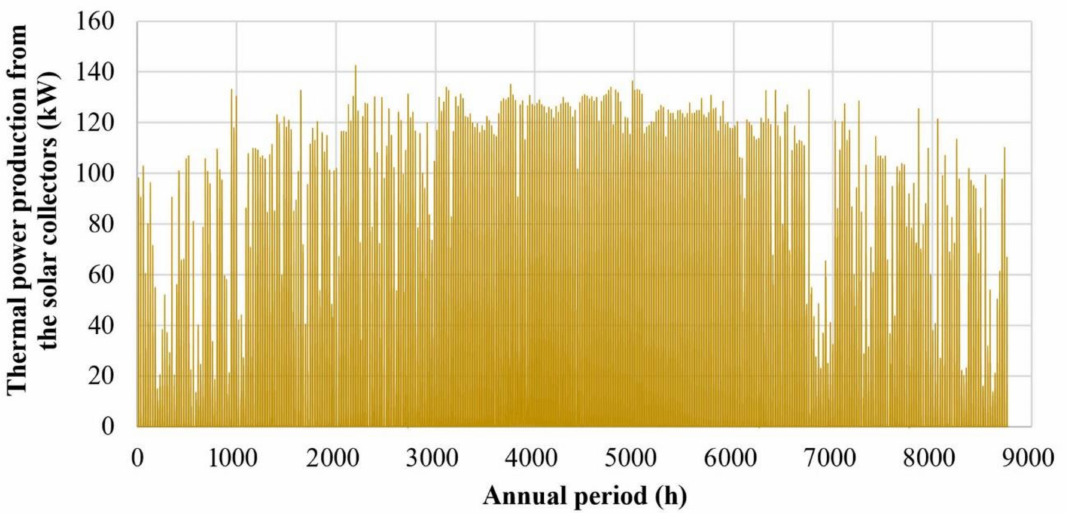
Figure 18. Annual fluctuation of the final thermal power stored in the thermal storage tanks by the solar